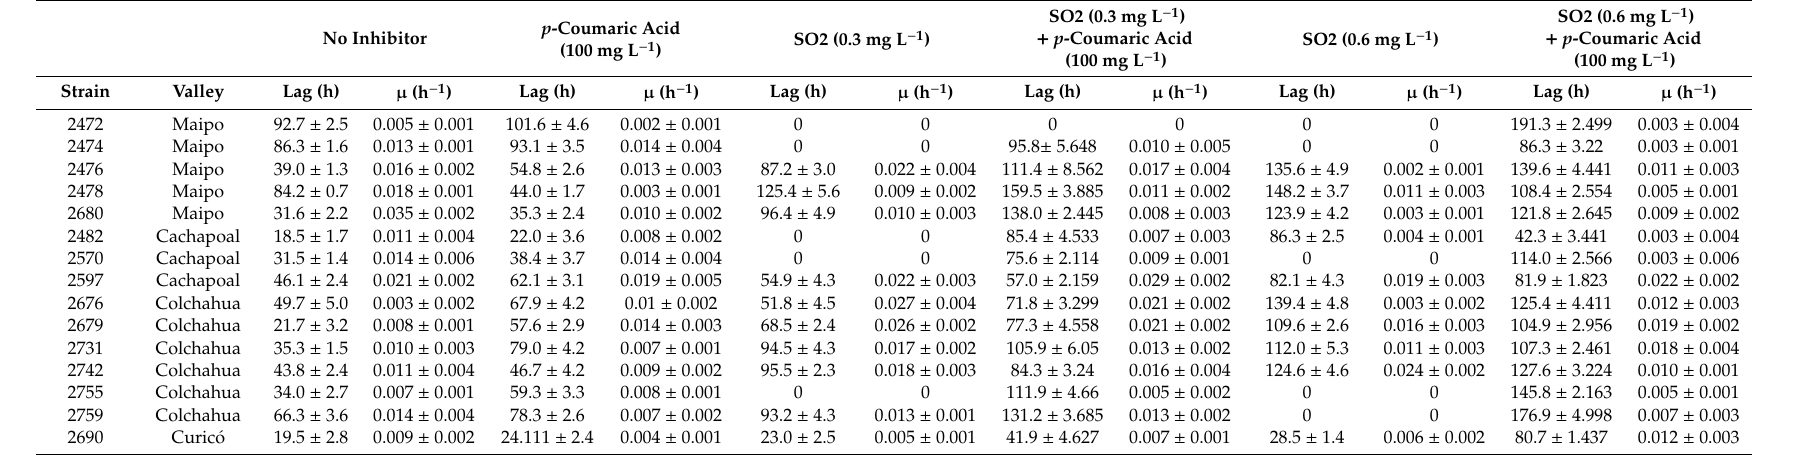
Table 2. Growth rate and extension of lag phase of Brettanomyces bruxellensis strains used in the study isolated from several wine-producing regions of Chile cultivated in synthetic medium in the absence or presence of p -coumaric acid and